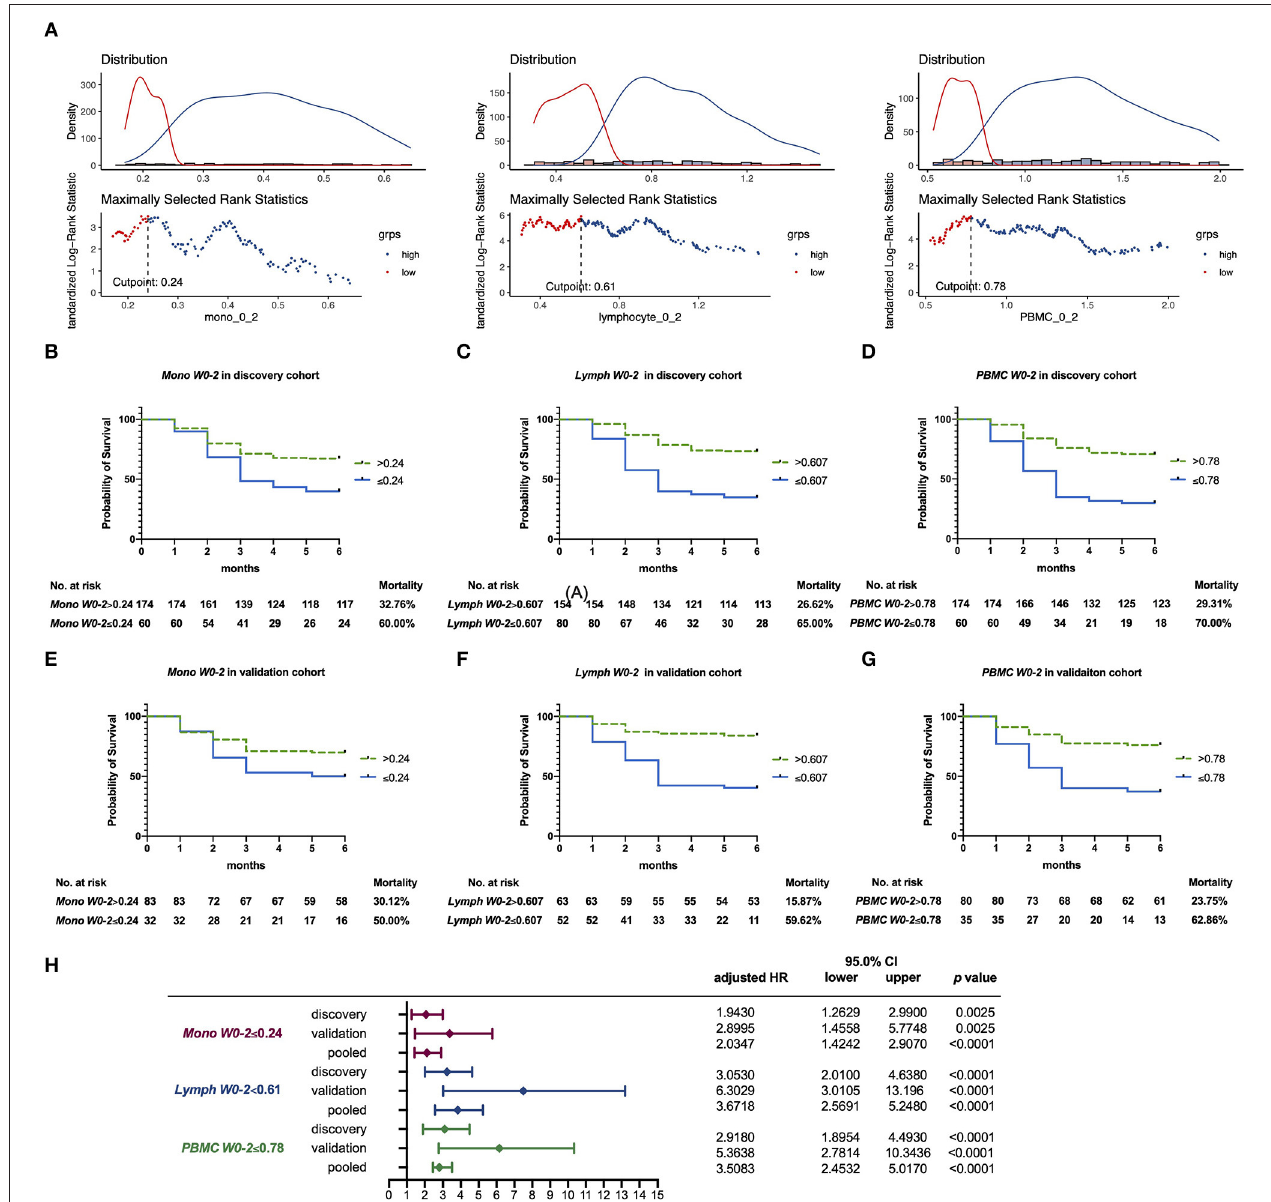
FIGURE 3 | (A) Optimal cutoff value for Lymph W0-2 , Mono W0-2, and PBMC W0-2 by the “survminer” R package, based on the discovery cohort. (B–G) The Kaplan–Meier survival curves displaying 6-month all-cause mortality, based on Mono W0-2 (with cutoff value of 0.24 × 10 9 /L), Lymph W0-2 (with cutoff value of 0.61 × 10 9 /L), and PBMC W0-2 (with cutoff value of 0.78 × 10 9 /L). (B–D) The Kaplan–Meier curve in the discovery cohort; (E–G) The Kaplan–Meier curve in the validation cohort. (H) Adjusted hazard ratio (HR) for average cell counts in two cohorts and in the pooled data, with age, gender, and IS